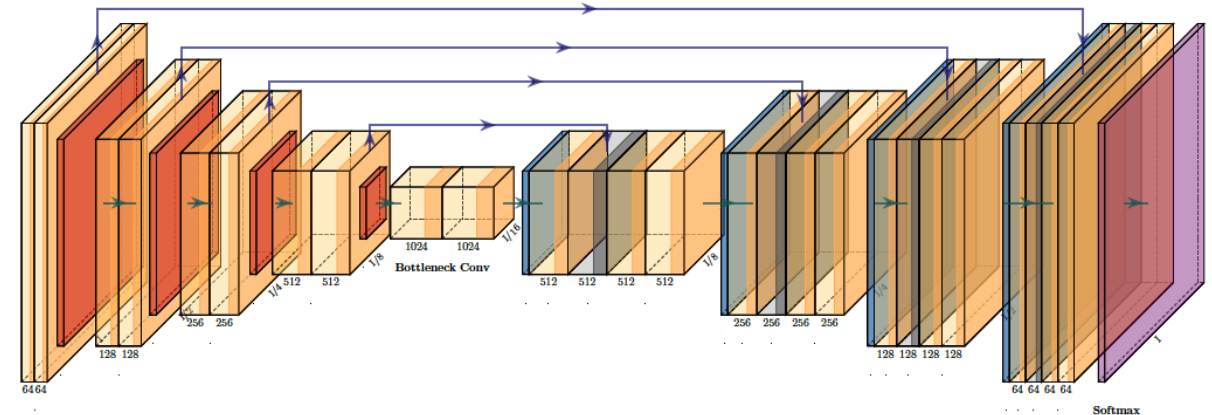
Figure 6. UNet [13] architecture. Green arrows depict forward connections, and purple arrows depict skip connections. ‘I/x’ denotes a downsampled, spatially reduced, input image ‘I’, while 64, 128, 256, and 512 denote the channel numbers at each layer.